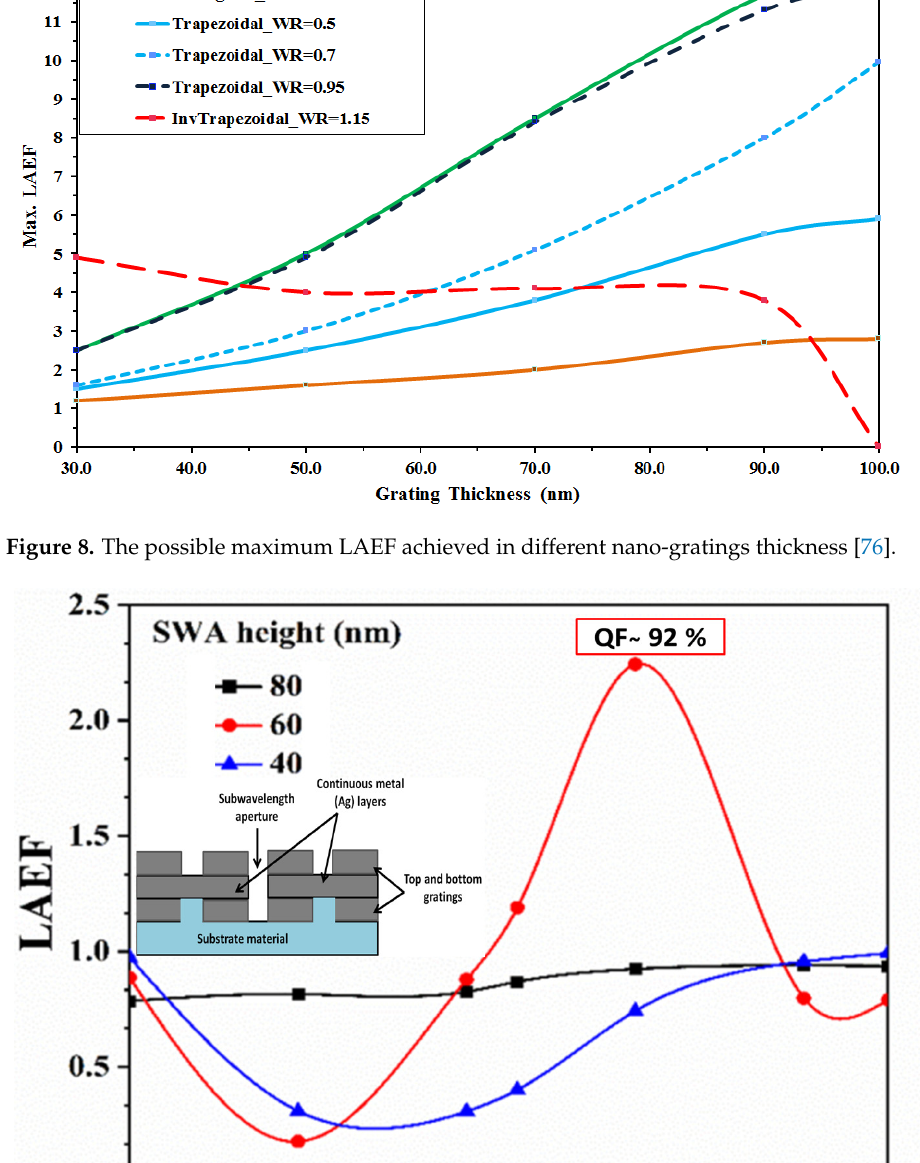
10 of 15 Figure 7. Light absorption enhancement factor (LAEF) spectrum of MSM-PD observed for various grating shapes with different slit-width, Traingel shape (a), Rectangular shape (b), Trapezoidal shape (c), and comparison of slit-width dependent maximum LAEF achieved for different nanograting structures [76]. On the other hand, the LAEF was found to be completely dependent on the grating thickness (with higher grating thickness up to a certain nm thick layer) leading to in- creased light absorption enhancement. Figure 8 shows the maximum peak of LAEF